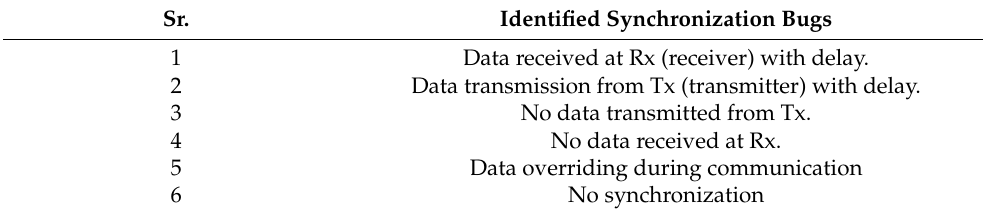
Table 1. Synchronization bugs in inter-processor communication. Sr.